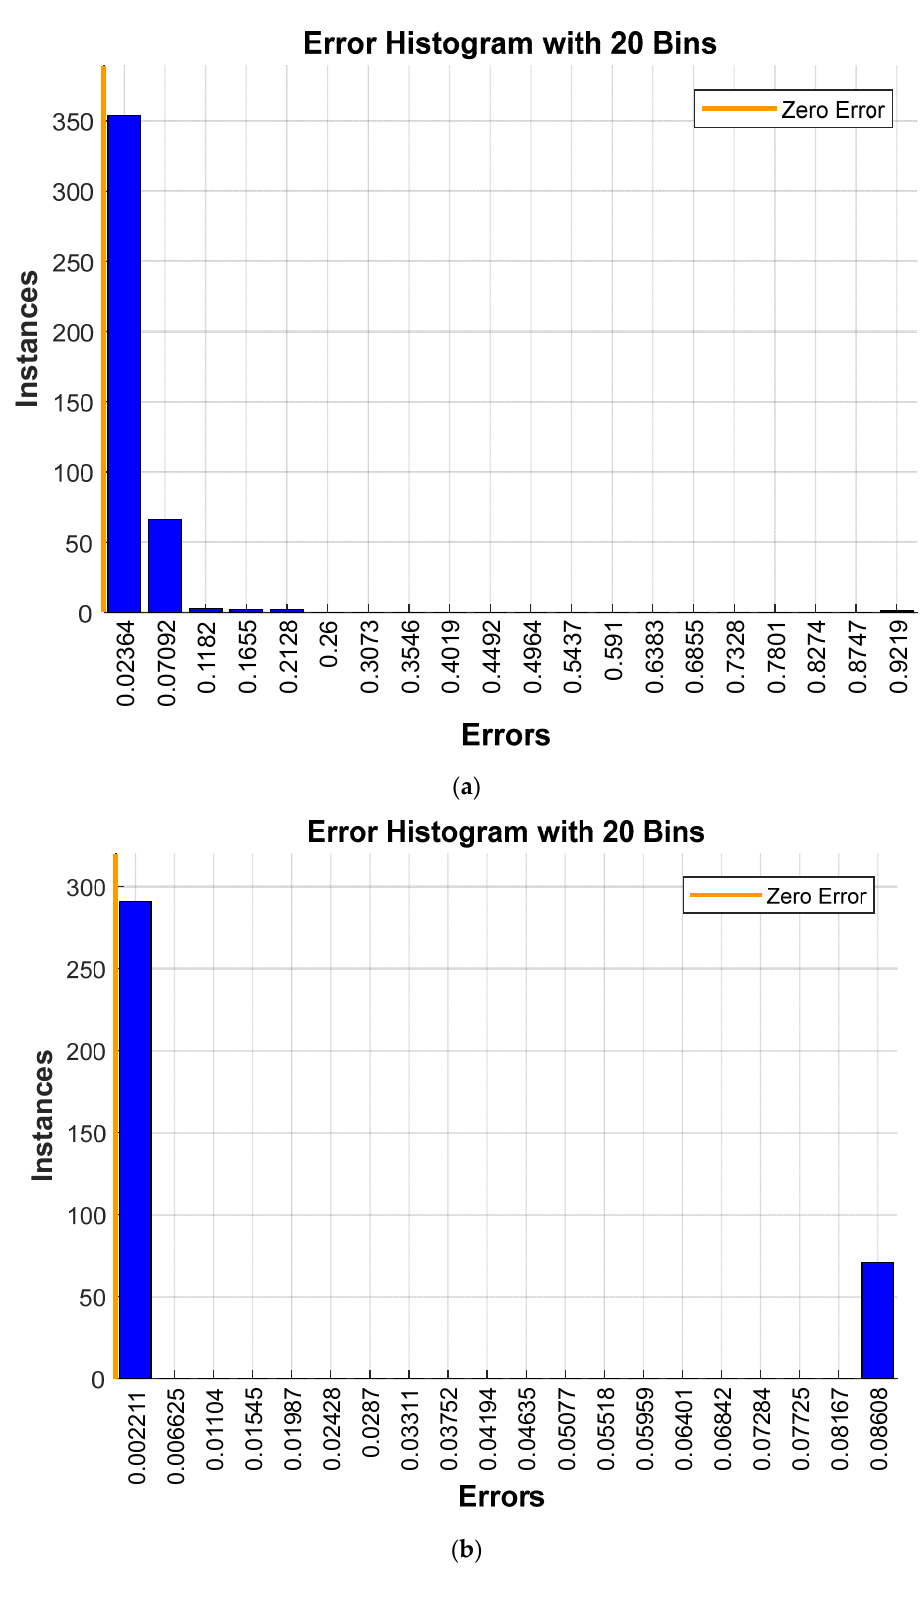
Figure 6. Error histograms for the developed GWO − GPR model in cast-in-place tunnel liners and concrete portal. ( a ) Cast-in-place tunnel liners. ( b ) Concrete portal.